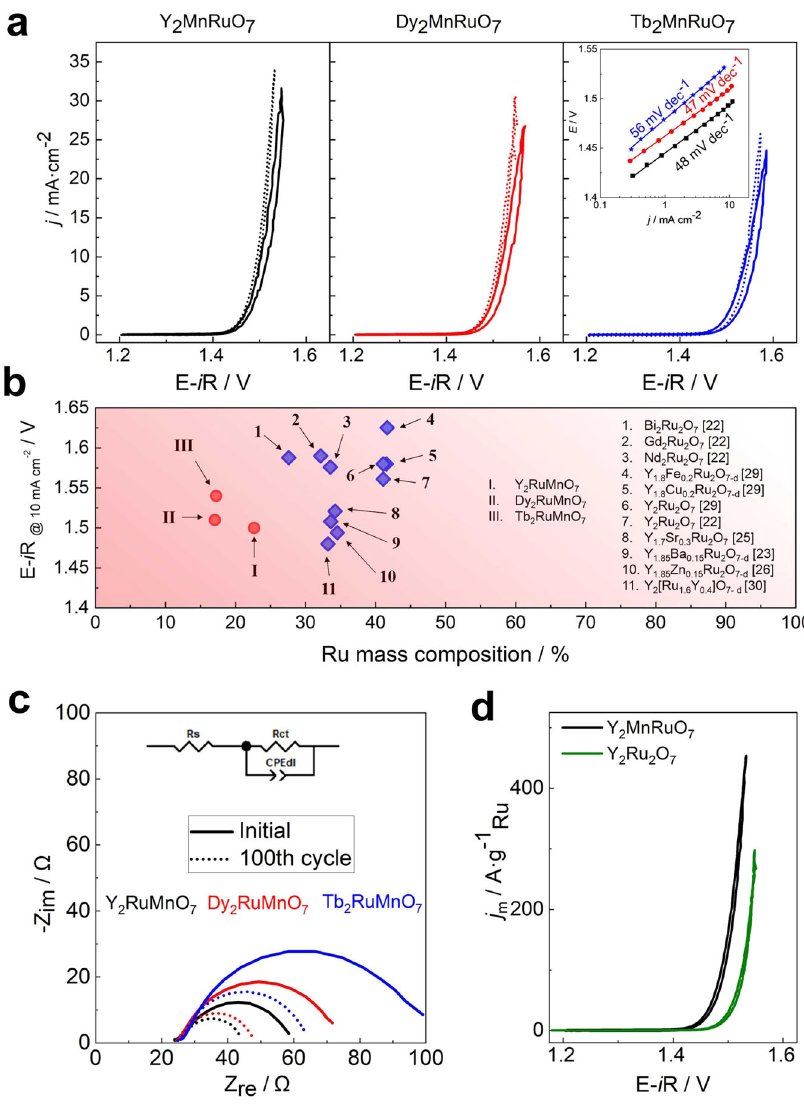
Fig. 2 | OER performance. a First (solid lines) and 100th (dotted lines) OER polarization curves for each catalyst recorded in O 2 -saturated 0.1 M HClO 4 at 10mVs − 1 and1600rpm.Inset:Tafelplotsafter100cycles. b Performanceofvarious Ru pyrochlores for the OER in acid electrolyte: those in this work are in red, and